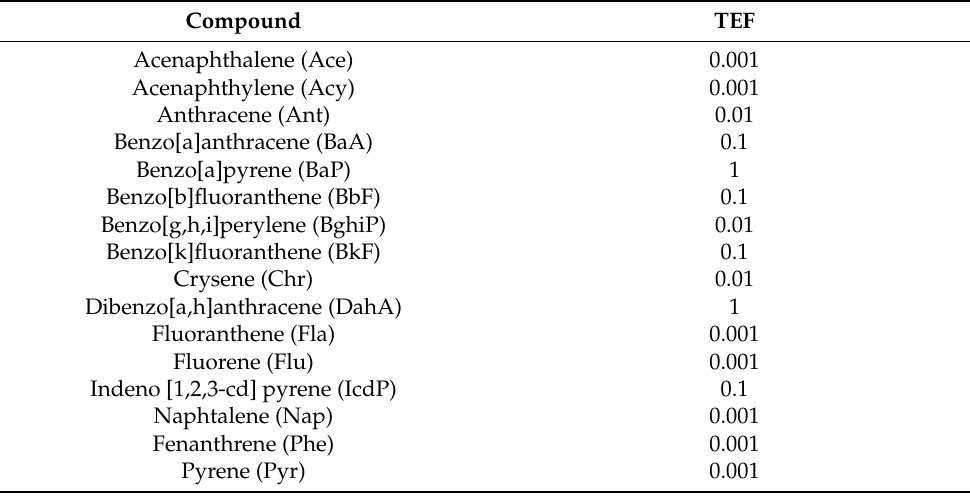
Table 5. Equivalent toxicity factors (TEF) of the 16 PAHs